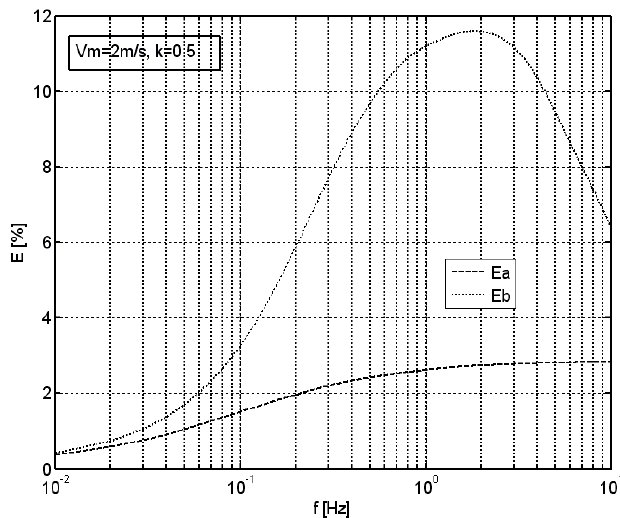
Figure 5. Relative error of the average velocity measured by an anemometer with ( Ea ) or without ( Eb ) the optimization system in the function of the frequency of rectangular excitation, v m = 2 m/s, k = 0.5.